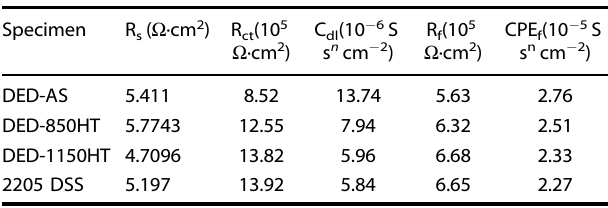
R s : solution resistance; R f : passive fi lm resistance; R ct : charge-transfer resistance of the Faraday processes; CPE f : constant phase element for the passive fi lm; C dl : capacitance of the electric double